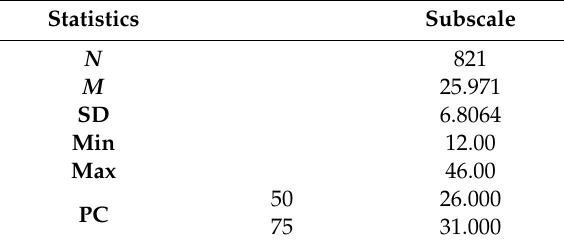
Table 2. Scores of the sum of positive and negative items on the social rights of